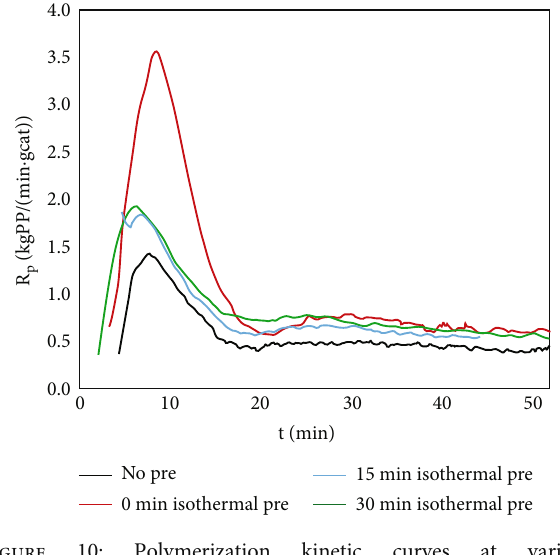
Figure 10: Polymerization kinetic curves at varied prepolymerization